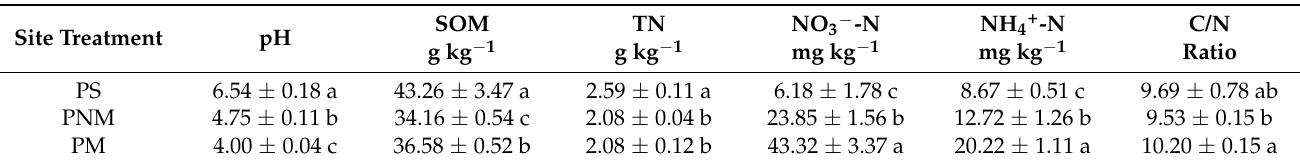
Table 1. Basic chemical properties of soils at the paddy field, P. plantation without mulching and P. plantation with mulching